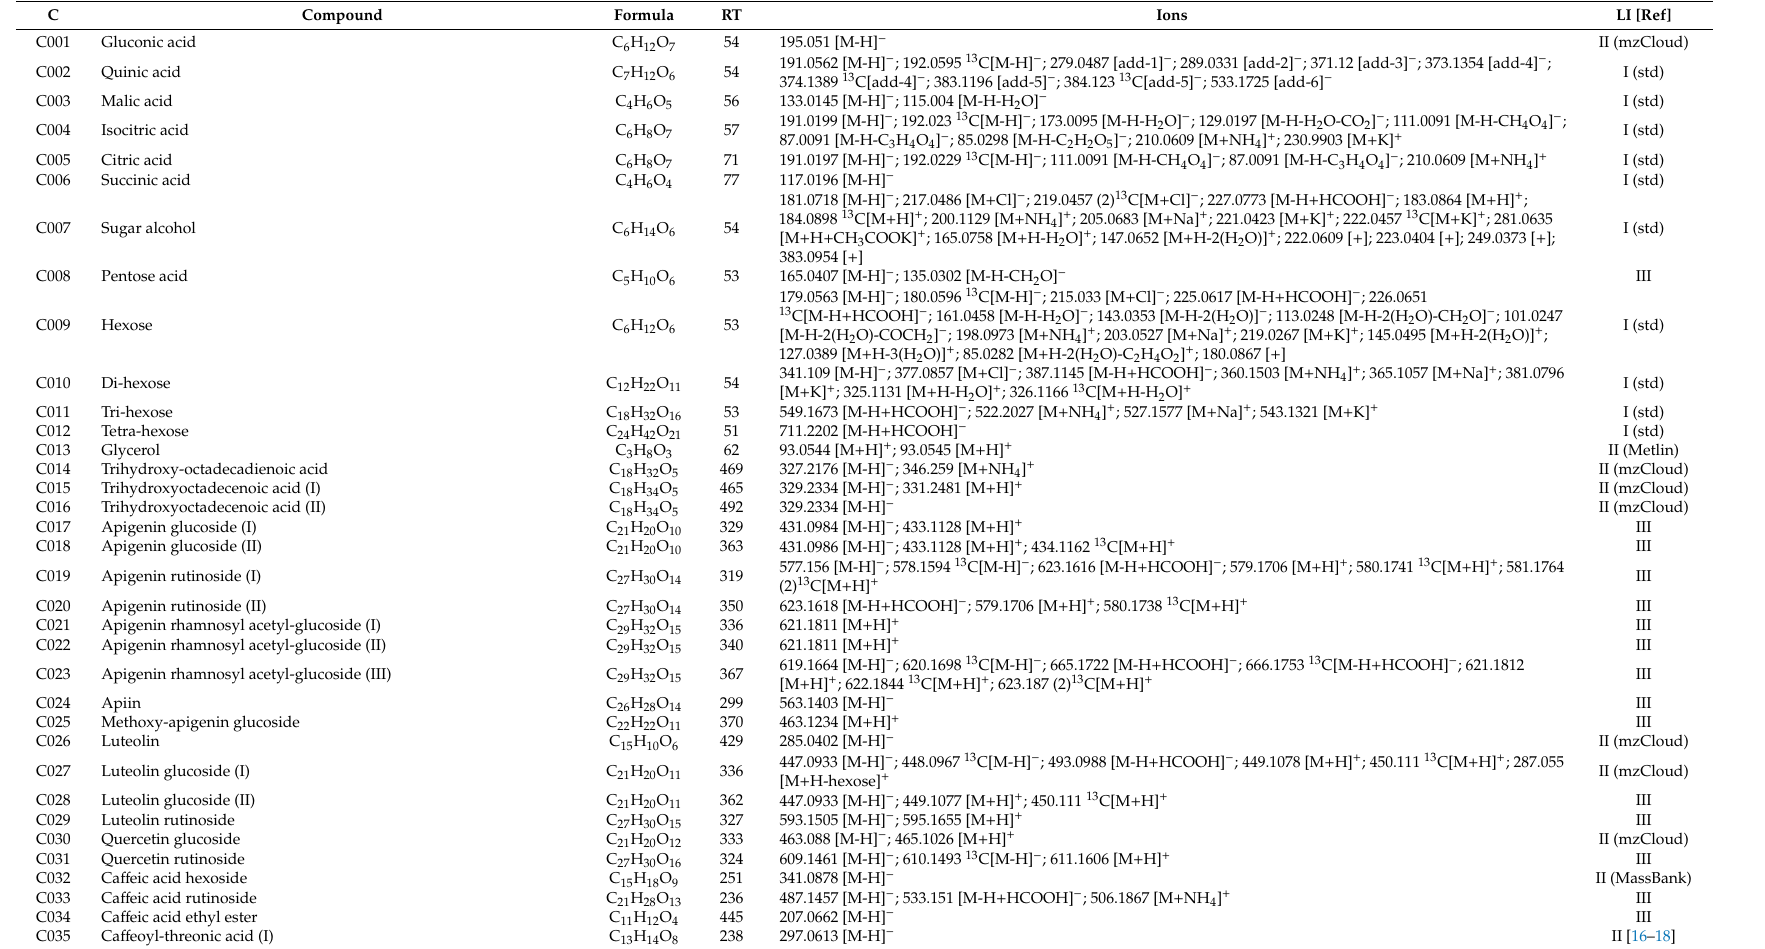
Table 1. Annotated compounds in study